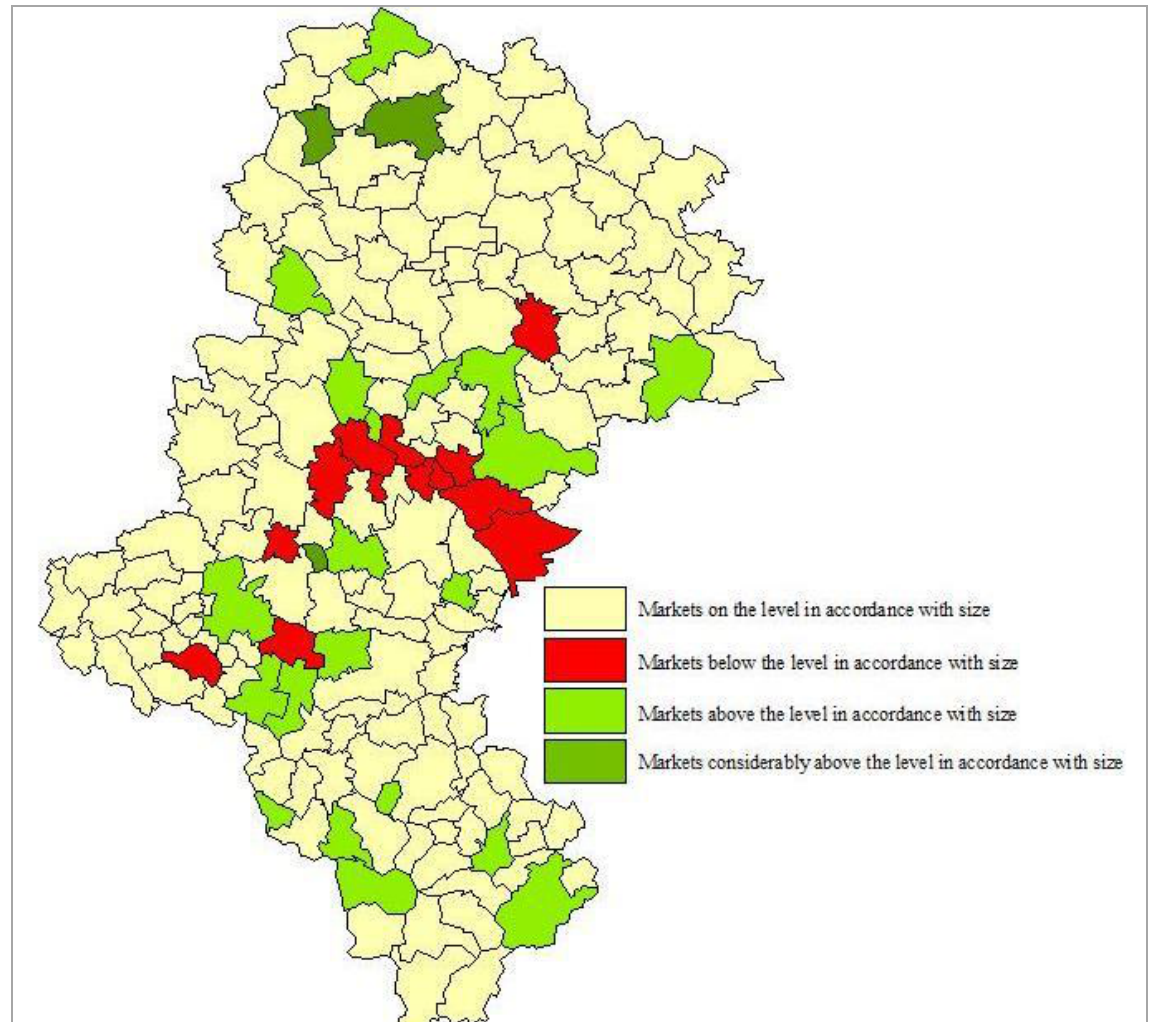
Fig. 2. Types of municipal labour markets in the Silesian